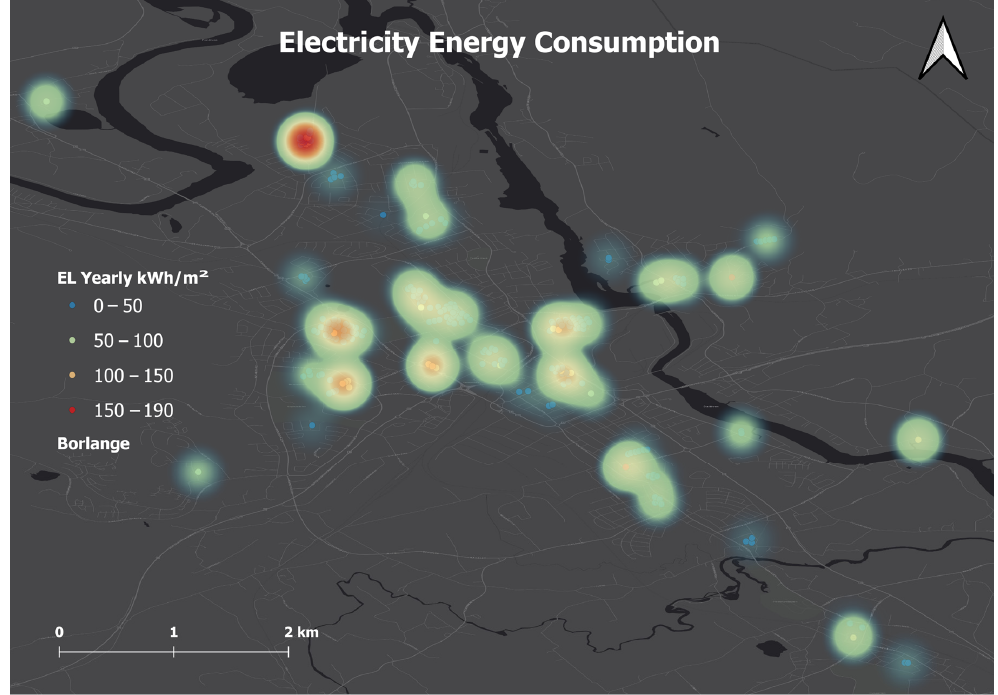
Buildings 2021 , 11 , x FOR PEER REVIEW Figure 6. Digital mapping of electricity use in Borlänge city based on building samples.